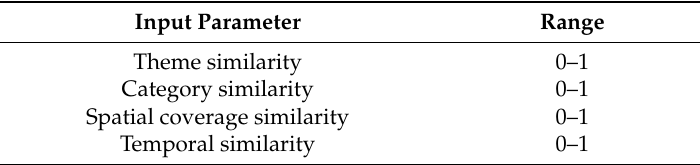
Table 6. Input parameters for our MLFFN and their ranges.